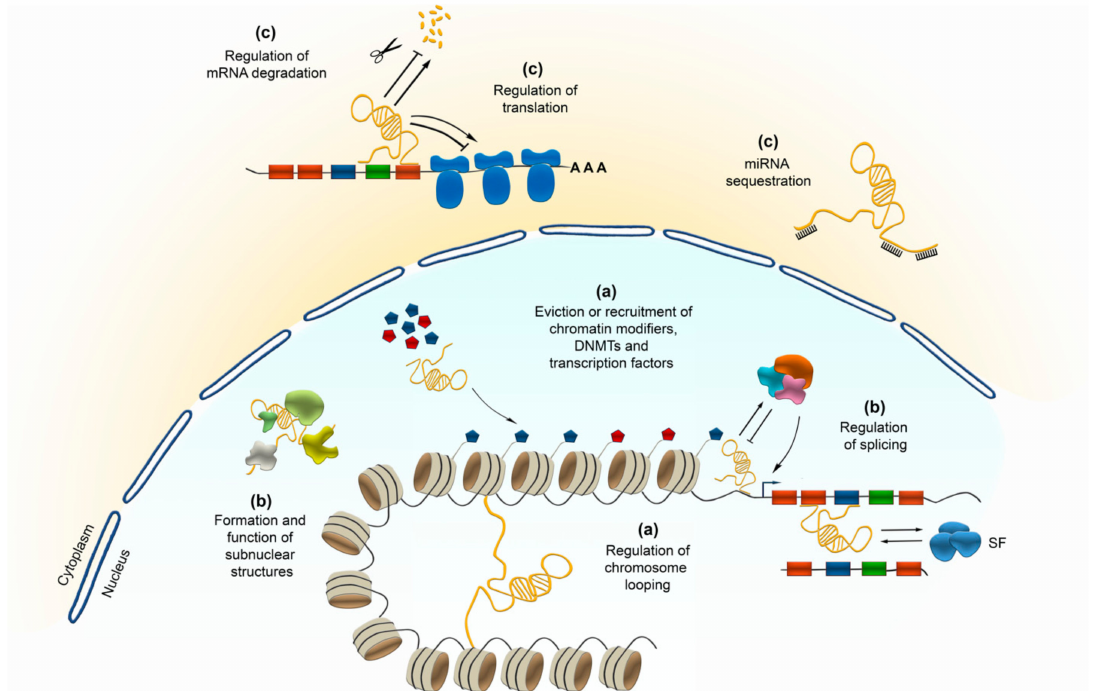
Figure 1. Potential functional diversity of long-noncoding RNAs (lncRNAs) in regulating transcription ( a ), posttranscriptional processes in the nucleus ( b ), as well as potential implications in interfering with translation ( c ) in the